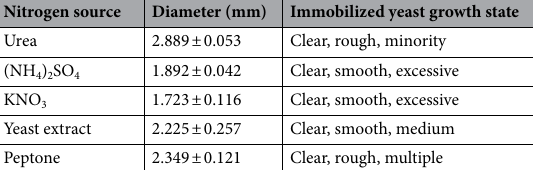
Table 4. Effect of different nitrogen sources on immobilized yeast.